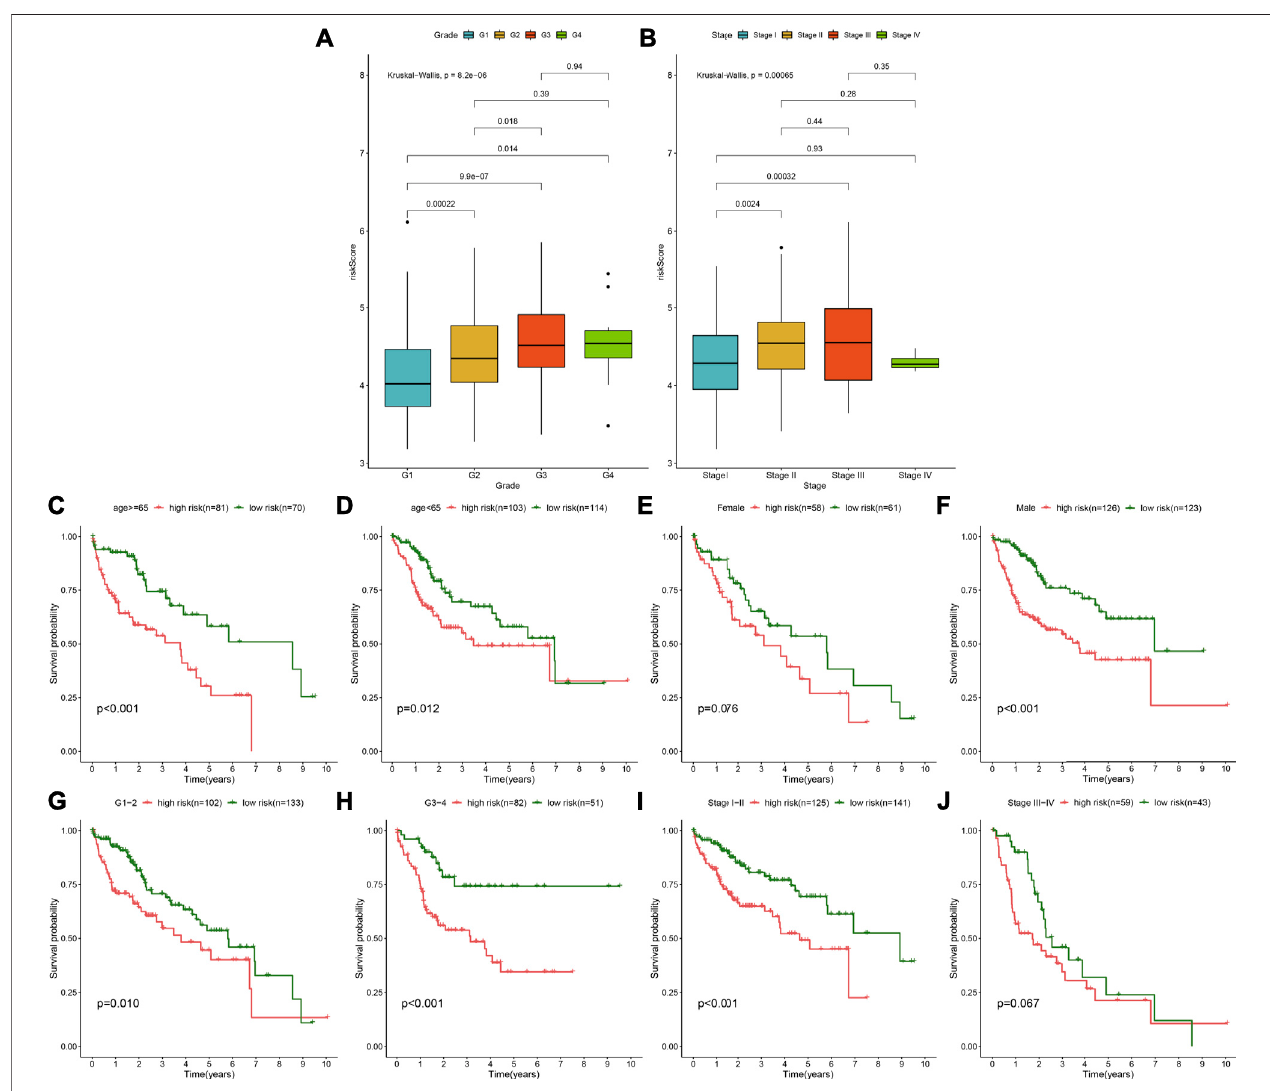
FIGURE5| AssessmentofthepredictivesensitivityoftheTLR-basedsignatureforHCCprognosisintheTCGAcohort. (A) ThedistributionoftheTLR-basedRSin differentgrades(G1-4) ofHCC. (B) Thedistribution oftheTLR-based RSindifferentstages (stage I-IV) ofHCC. p valueswereestimated withKruskal – Wallis tests. (C – J) Subgroup analysis of prognostic value of the TLR-based signature for HCC patients by Kaplan – Meier curves according to clinicopathologic characteristics: (C) age > (cid:1) 65 and (D) age < 65; (E) female and (F) male; (G) grade 1 – 2 and (H) grade 3 – 4; (I) stage I-II and (J) stage III-IV. Survival differences were estimated through log- rank